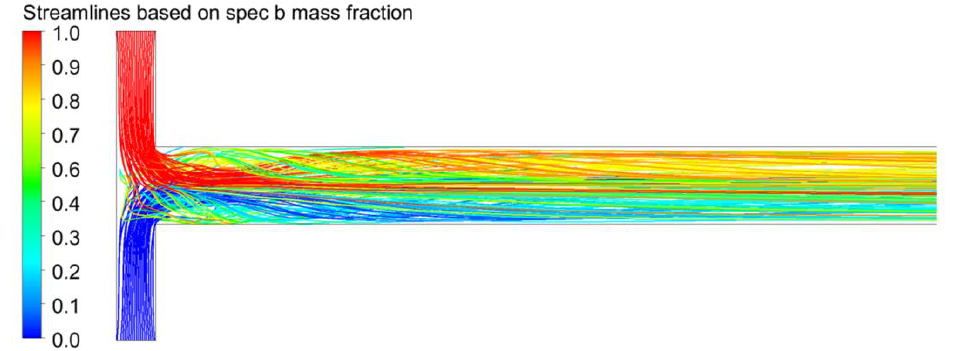
Figure 16. Streamlines from top view of T-mixer at Re = 345